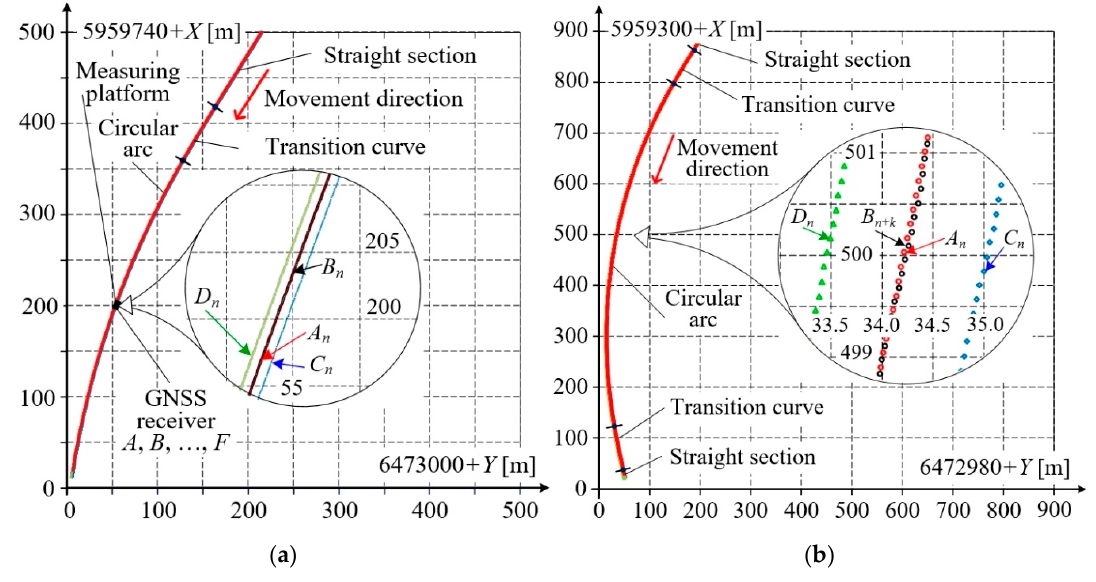
Figure 11. Results acquired on a geometrically complex railway track segment: ( a ) straight section changing to circular arc; ( b ) section consisting of transition curves and circular arc.